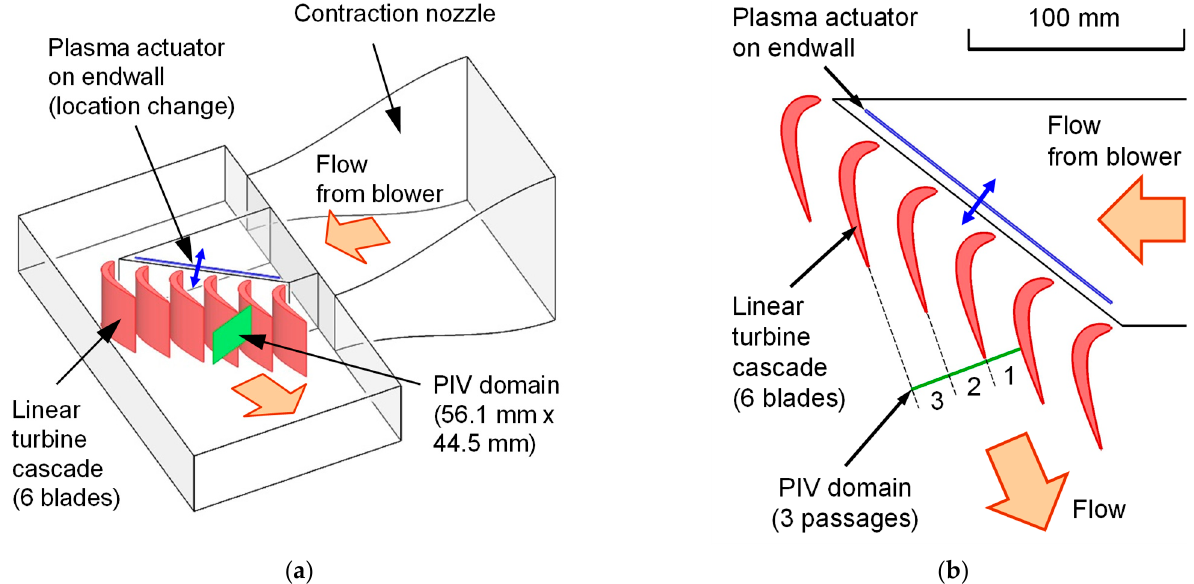
Figure 3. Test section of the linear turbine cascade: ( a ) overall view; ( b ) top view and blade geome- try.